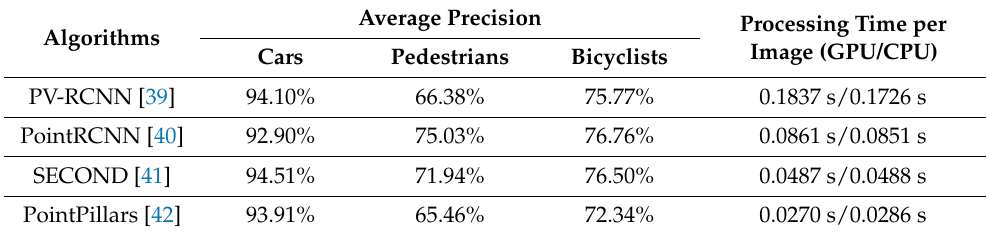
Table 5. Comparison of various 3D object detection algorithms based on the KITTI dataset. Average Algorithms